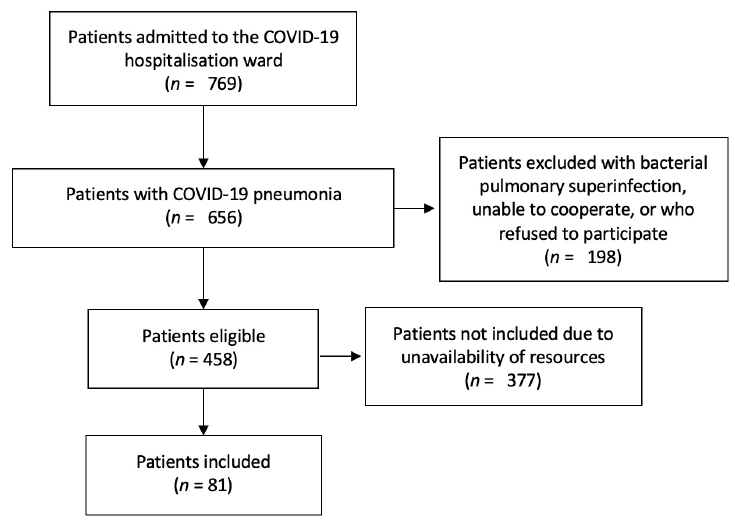
Figure 2. Patient selection flow chart.